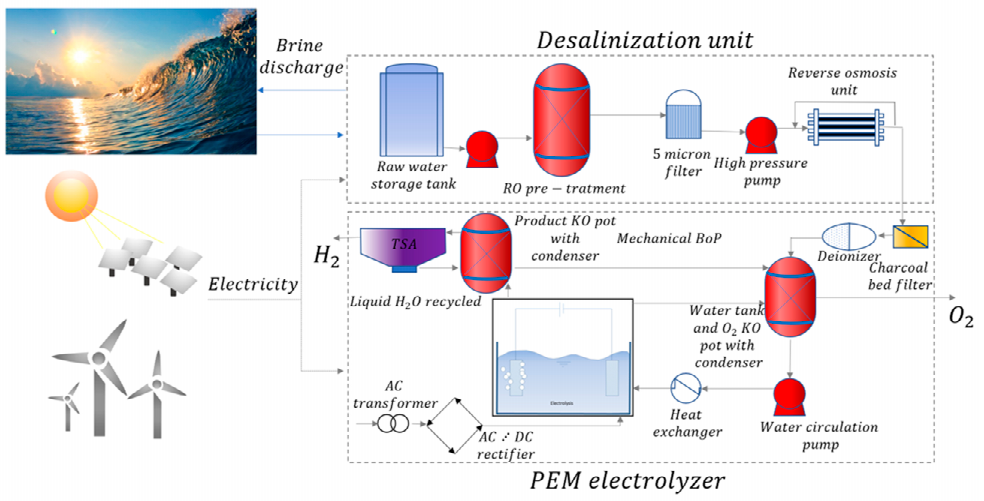
Figure 10. Seawater desalinization for hydrogen production.